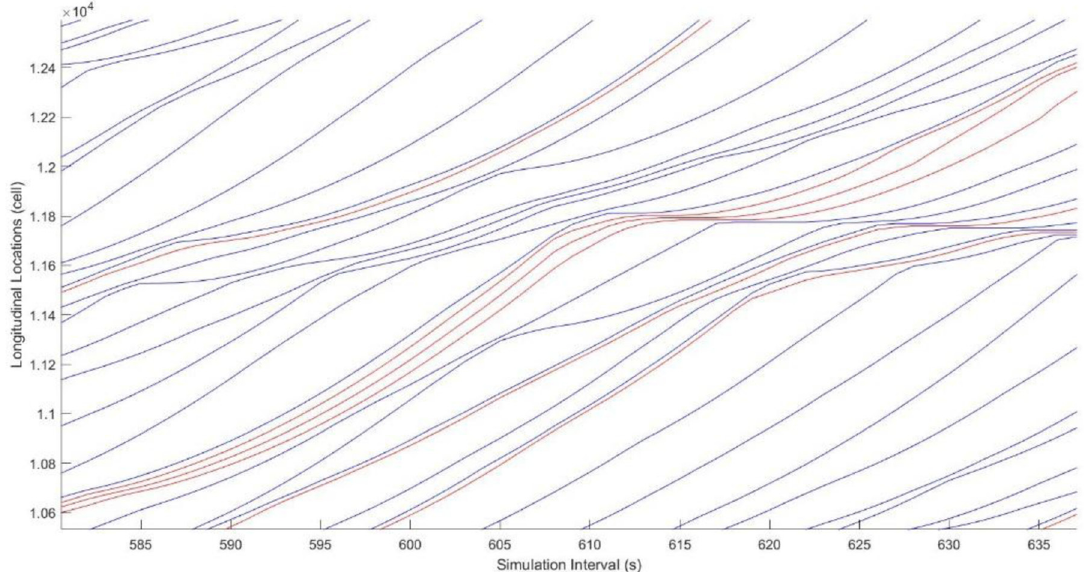
Figure 4 Following model performance analysis based on trajectories